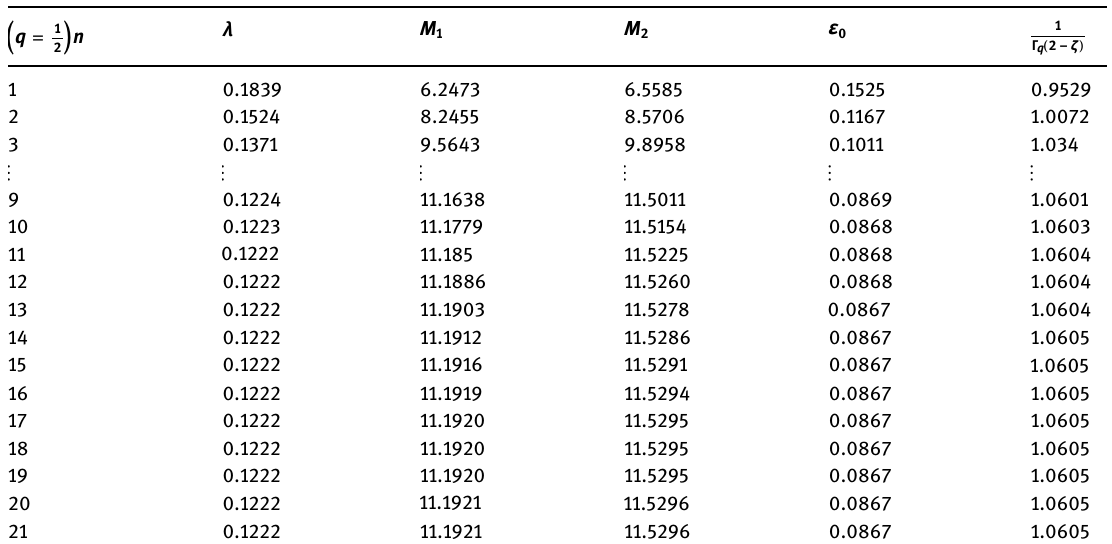
1 in Example 4.2 for ∈ t J and = q Γ 2− q ( ) ζ